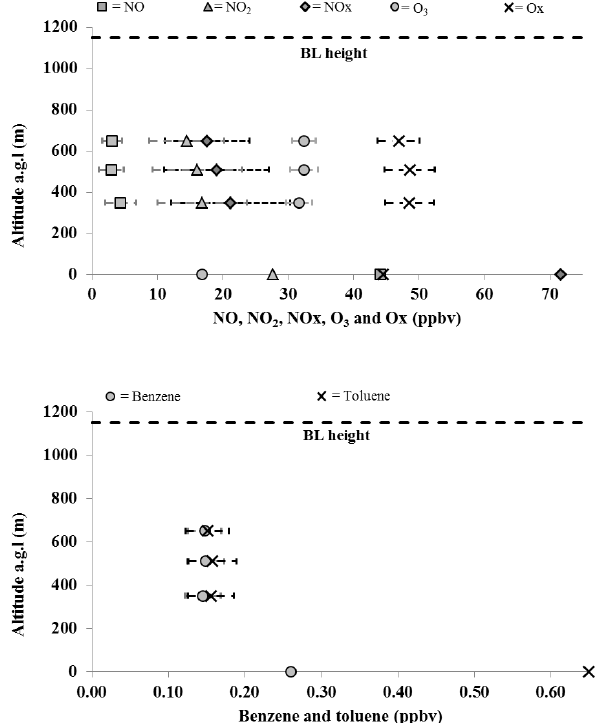
Figure 7. Average vertical profiles of O 3 , NO, NO 2 , O x , benzene and toluene across London during RF1, 17:00–18:00 local time, on the 24 June 2013. X error bars represent standard deviation (1 σ) of mixing ratios observed during each flight leg. Mixing ratio at ground level is hourly average from the LAQN Marylebone Road air quality monitoring